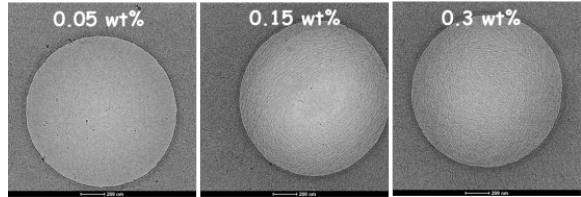
Fig. 2. Shear viscosity of cetylamidopropyl hydroxypropyl sulfobetaine and tetradecyl propyl sulfobetaine solution at different temperatures (a) and shear viscosity diagram of cetylamidopropyl hydroxypropyl sulfobetaine/tetradecyl propyl sulfobetaine composite system (b) in brine (Salinity=9000 mg·L-1, [Ca 2 + ] + [Mg 2 + ] = 900 mg·L − 1 , T=65 o C, concentrations vary from 0.05 wt% to 0.5 wt%).